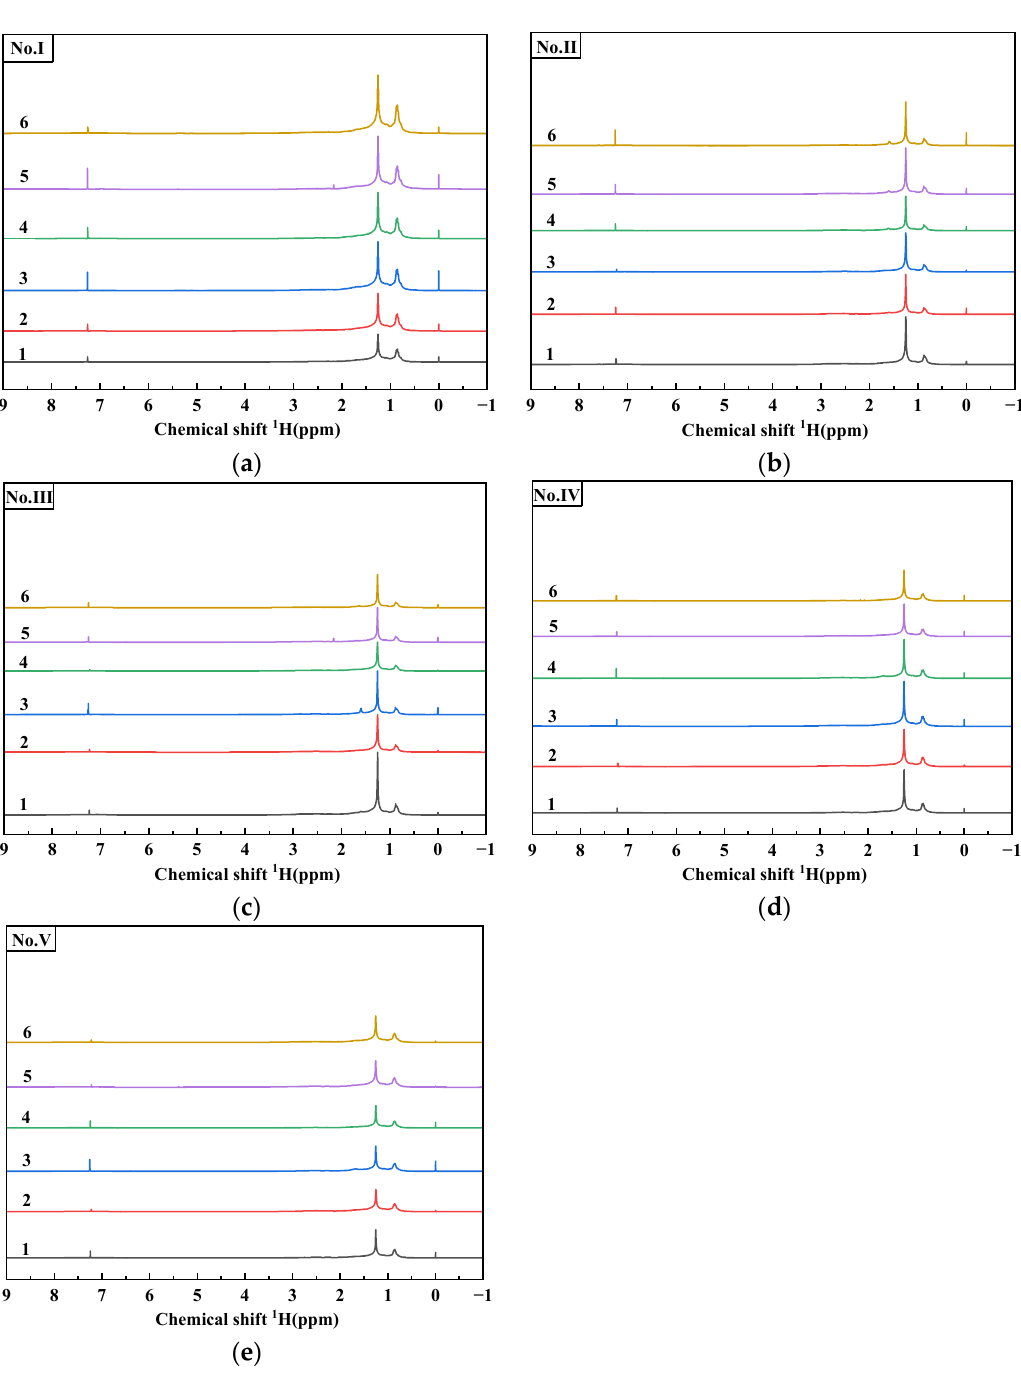
Figure 2. 1 H-NMR spectra of bitumen samples. ( a ) asphalt No. I; ( b ) asphalt No. II; ( c ) asphalt No. III; ( d ) asphalt No. IV; ( e ) asphalt No. V.